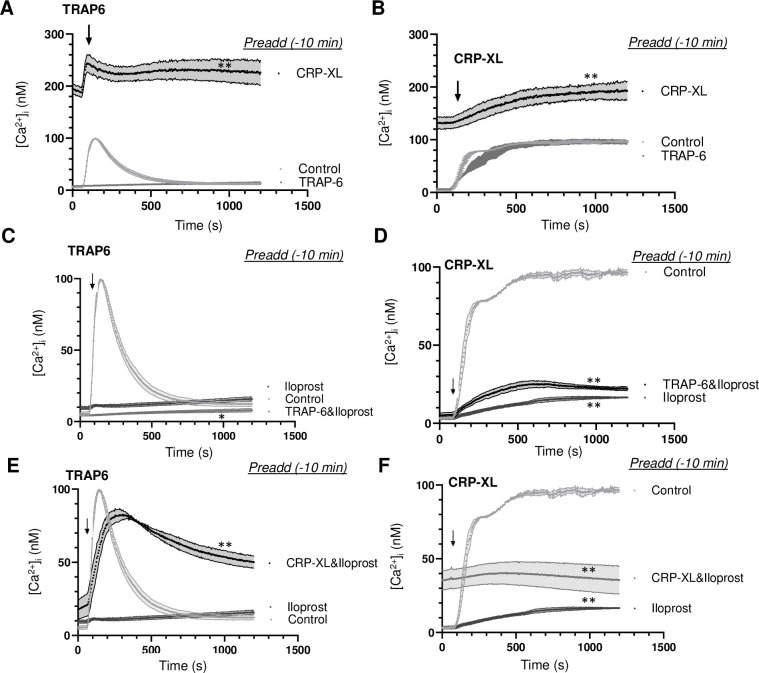
Recurrent Ca2+ signal generation induced by consecutive agonists.Calibrated [Ca2+]i rises were recorded during 25 min of Fura-2-loaded platelets in 96-wells plates. Platelets were stimulated at indicated time point (arrow) as second agonist with 10 μM TRAP6 (A, C, E) or 5 μg/mL CRP-XL (B, D, F). (A, B) Preaddition of vehicle (control), TRAP6 (10 μM) or CRP-XL (5 μg/mL) at 10 min before second agonist. (C, D) Preaddition of vehicle control or iloprost (10 nM) with/without TRAP6 (10 μM) at 10 min before second agonist. (E, F) Preaddition of iloprost (10 nM) with/without CRP-XL (5 μg/mL) at 10 min before second agonist. Means ± SEM (n = 3 experiments). *P<0.05, **P<0.001 vs. controls at t = 1000 s, paired Student t-test.